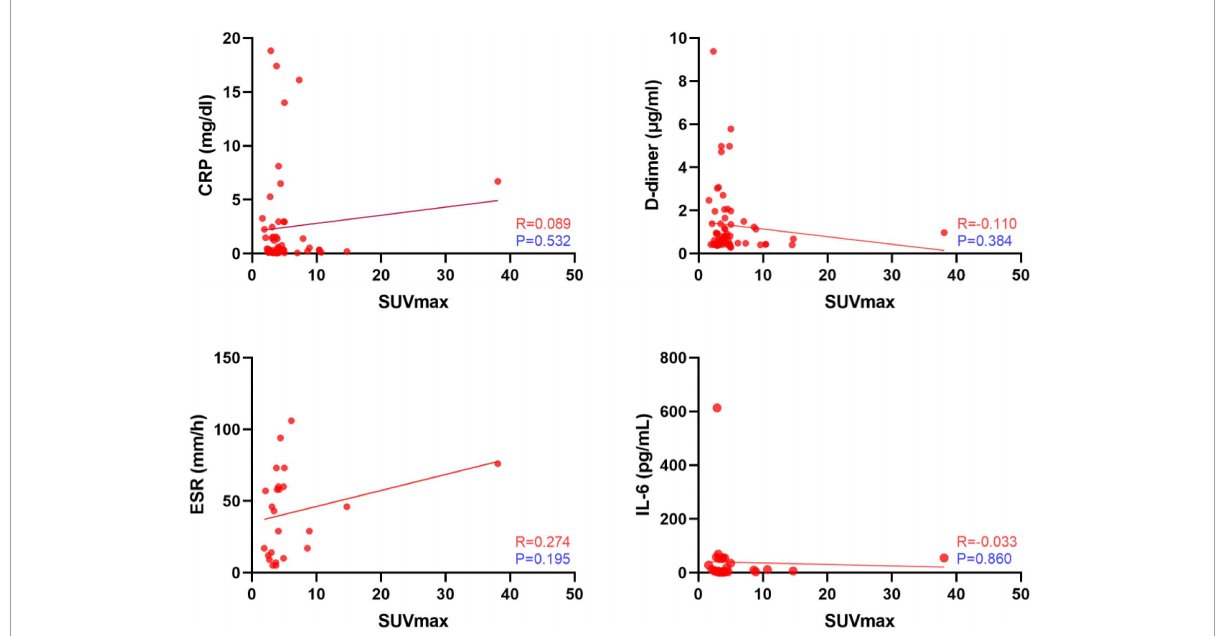
FIGURE3 Linear regression analysis between standardized uptake values (SUV max ) and serologic test results.